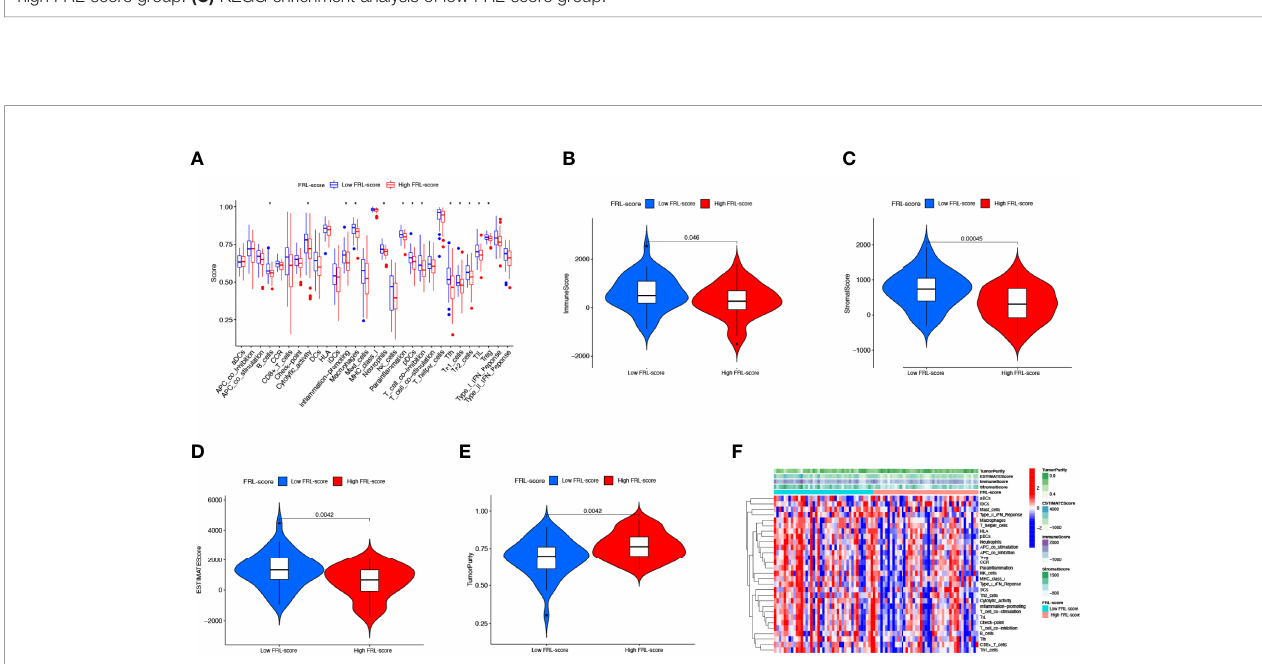
FIGURE 9 | Immune characteristics of different FRL-score subgroups. (A) Disparities in immune cell in fi ltration and immune functions between different subgroups in the TARGET set. (B) Comparison of the immune scores between different FRL-score subgroups. (C) Comparison of the stromal scores between different FRL-score subgroups. (D) Comparison of the ESTIMATE scores between different FRL-score subgroups. (E) Comparison of tumor purity between different FRL-score subgroups. (F) Heatmap of the distinctions in immune microenvironment characteristics between the two